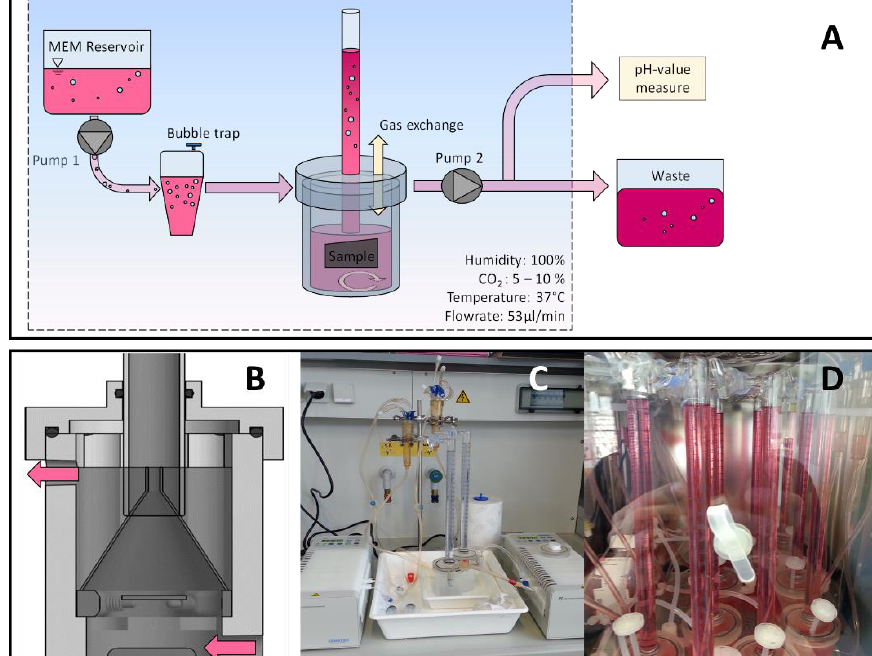
Figure 1. Bioreactor design. ( A ) Each bioreactor cell was independently connected through Versilic silicon tubes to tworeservoirs filled with minimum essential medium (MEM) (1). The medium was pumped by a multichannel roller pump (2) to each bioreactor (3). To avoid the falsification of measurents by foreign gas bubbles in the system, a bubble trap was installed between the first pump and the bioreactor itself (4). A second pump (5), in sync with the first one, allows for the removal of MEM from the degradation chamber towards a waste reservoir (6). Before the second pump, a split line allows for the aliquotation of small volumes of MEM for pH measurements (7). In order to reduce the risk of medium contamination, a PTFE filter acts as a particle barrier between the two compartments (8). ( B ) Schematic illustration of a bioreactor. The flow of the medium is shown by the direction of the arrows and the holder for the specimens is encircled. ( C, D ) Illustrative photographs of the bioreactor cells before ( C ), and throughout the experiment ( D ).